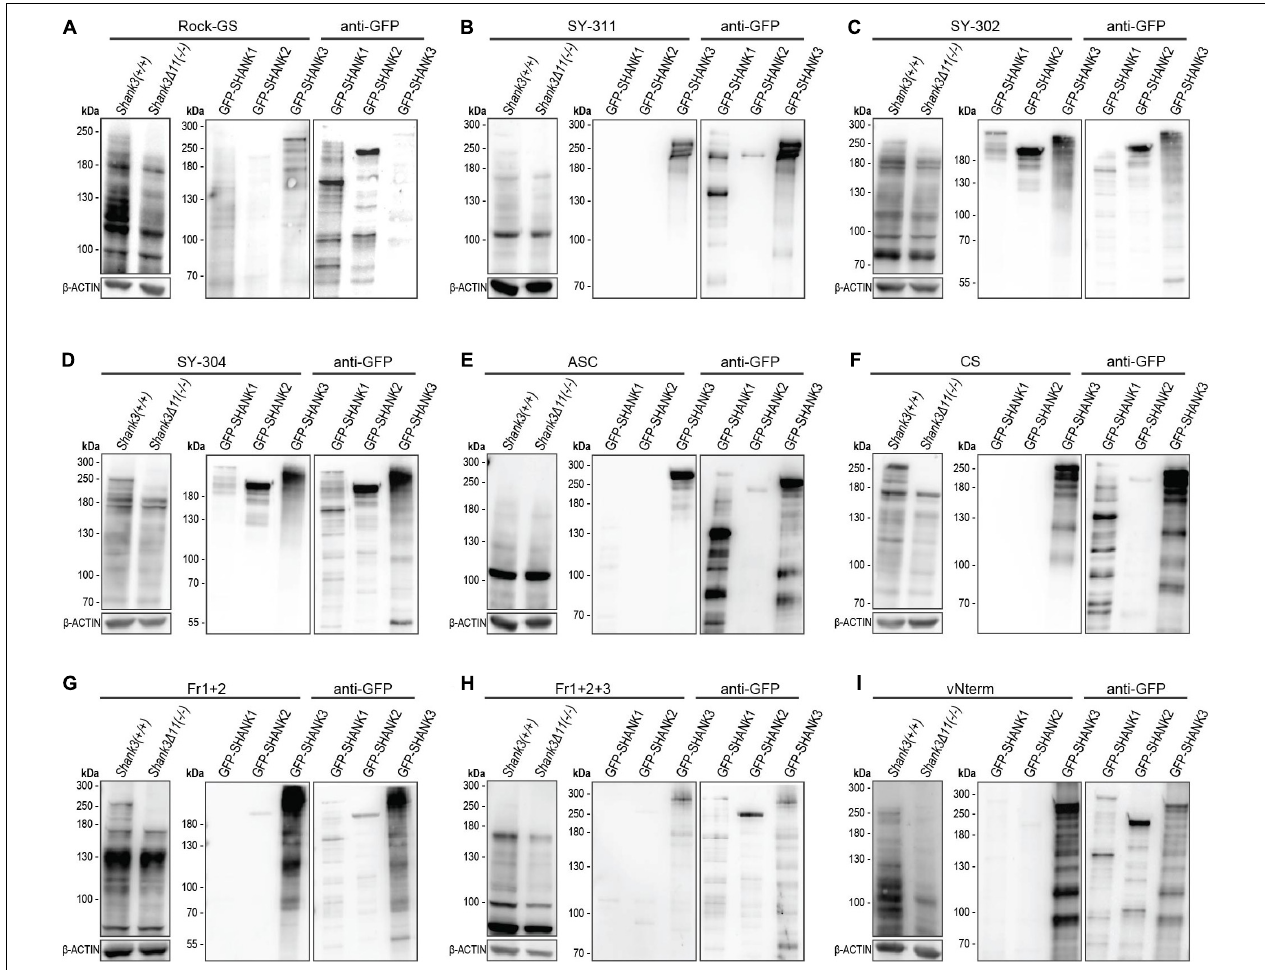
FIGURE 2 | Western Blot analysis for SHANK3 specificity. (A) Rock-GS, (B) SY-311, (C) SY-302, (D) SY-304, (E) ASC, (F) CS, (G) Fr1+2, (H) Fr1+2+3, and (I) vNterm. Left: The Western Blot shows mouse cortical lysate of WT and KO mice for all antibodies. Same amounts of protein are ensured by β -ACTIN. Right: GFP-SHANK1, GFP-SHANK2, and GFP-SHANK3 were overexpressed in HEK293T cells. Blot were first incubated with the respective SHANK3 antibody and then with an anti-GFP antibody to ensure plasmid